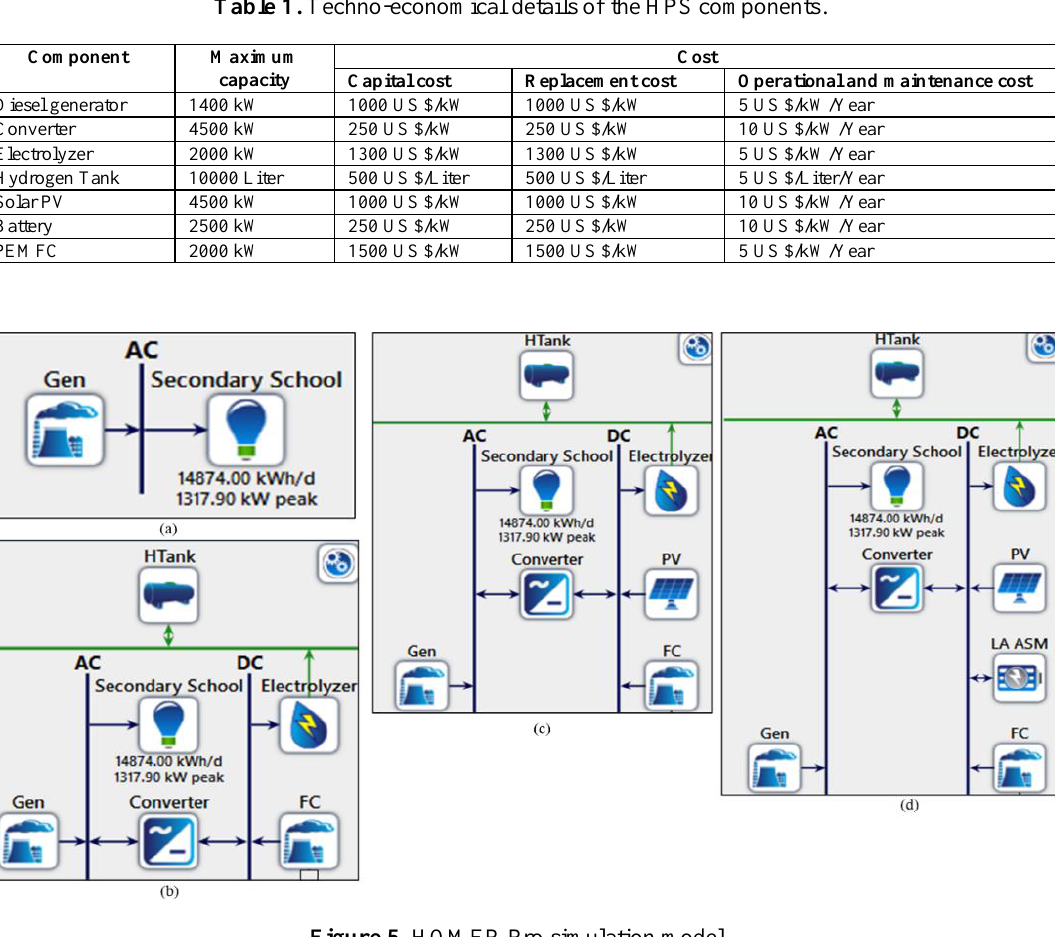
Figure 5. HOMER Pro simulation